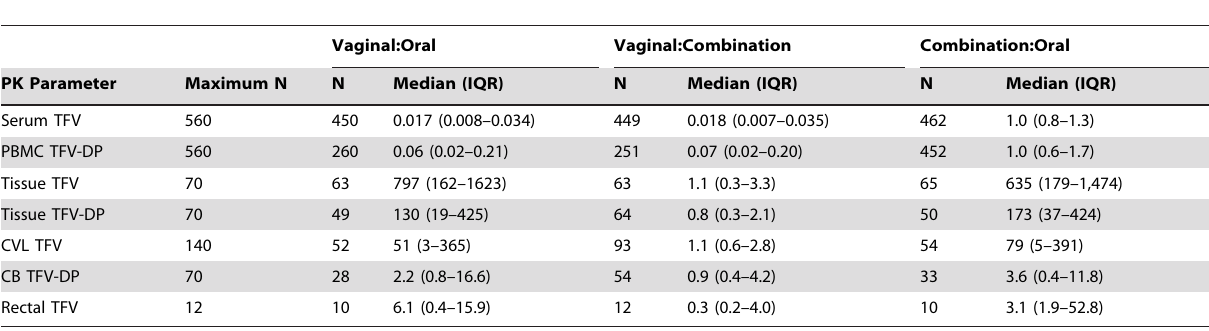
Table 4. Concentration ratios between dosing period by anatomic location.